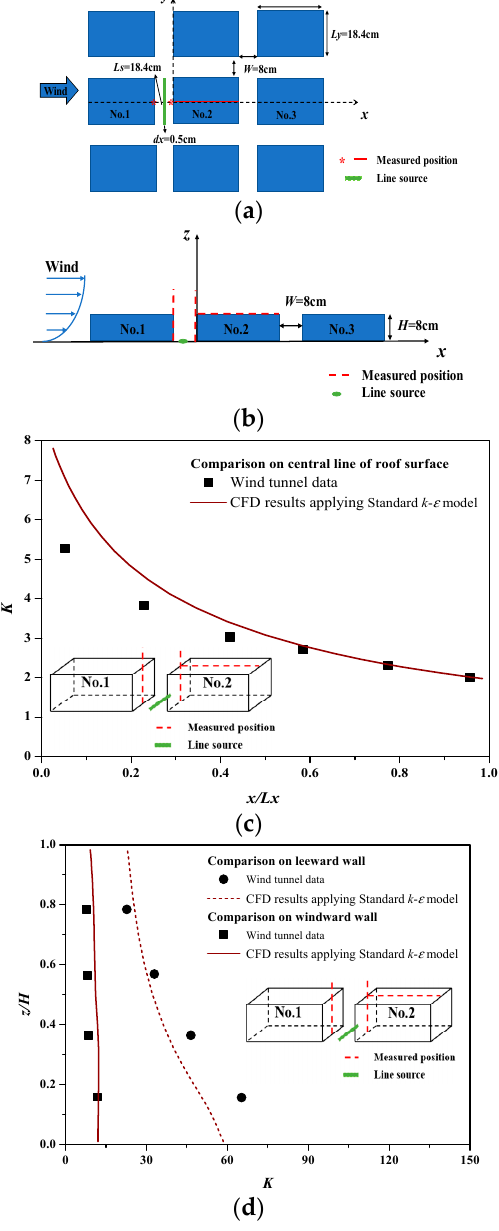
Figure A2. Validation for pollutants dispersion model. ( a ) Configurations of the wind-tunnel experiment with top view. ( b ) Configurations of the wind-tunnel experiment with lateral view. ( c ) Vertical profiles of normalized inert gas concentration K at the roof top of the model. ( d ) Vertical profiles of K at the leeward and windward wall.